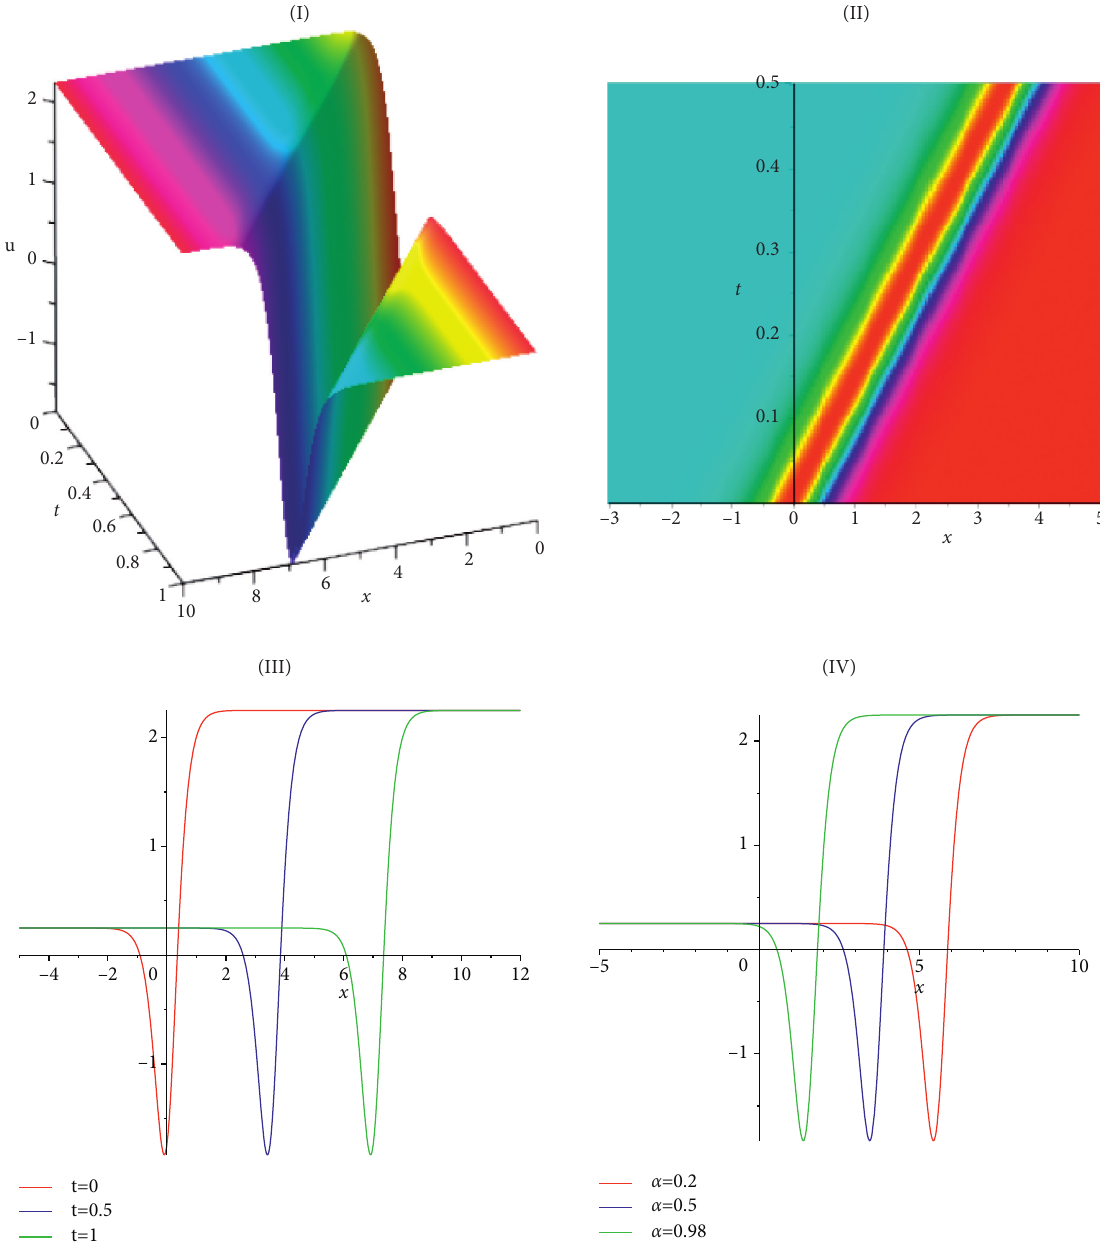
Figure 2: Evolution of the periodic solution (25) with data r � , k